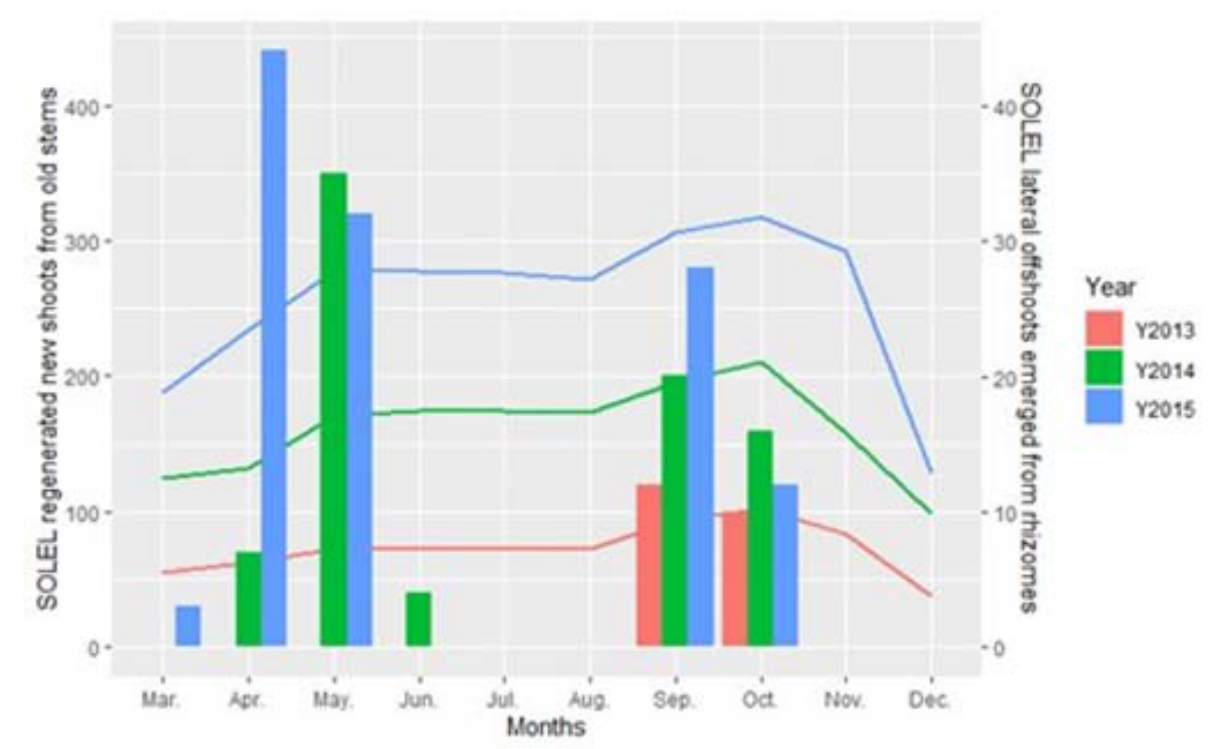
Figure 3. Solanum elaeagnifolium new shoots regeneration from old stems and lateral offshoots emer- gence from rhizomes during three growing cycles (2013, 2014, and 2015), following its transplantation in an open field at Chott Mariem, Tunisia, in autumn 2012.